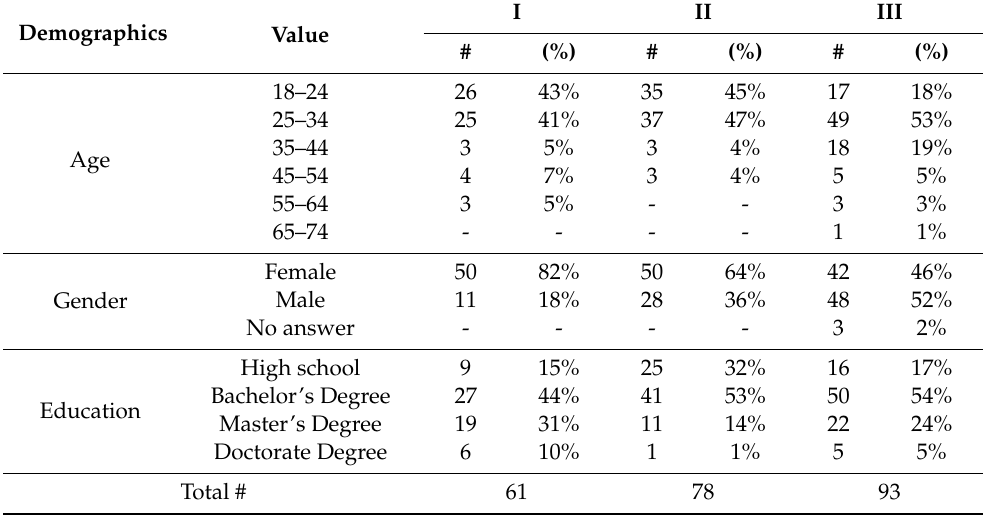
Table 2. Descriptive statistics of the samples in Studies